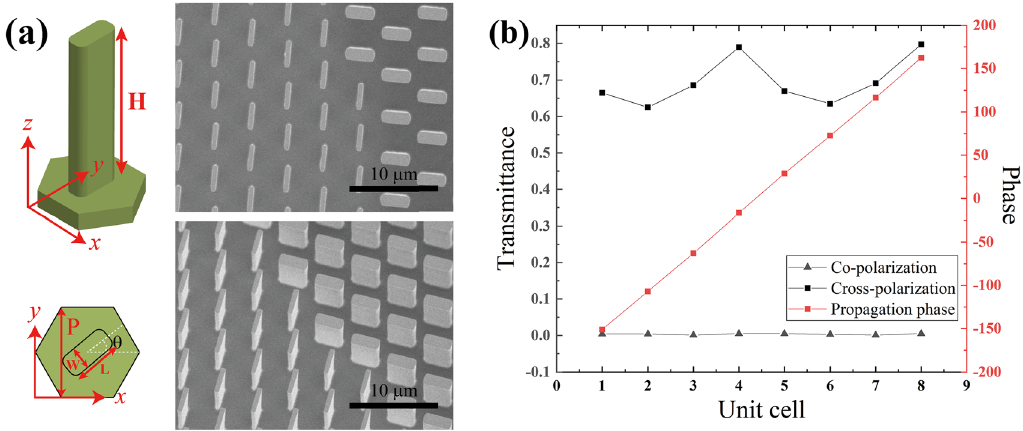
Figure 2: Design and simulation results of the unit cells. (a)Schematicimagesoftheunitcellandscanningelectronmicroscope(SEM)imagesofthesamples.Ahexagonalshapeisdesignedbecause the circular symmetry of the hexagonal shape is higher than the square, leading to more uniform responses of the unit cells at different rotation angles for Pancharatnam-Berry (PB) phase. The period P of the unit cell and the height H of the pillar are 4.8 and 7 μ m, respectively. The edges of the pillar in this design are bent by a radius of W /4, where W is the width of the pillar. (b) Simulation results of eight unit cells includingco-polarization,cross-polarizationtransmittanceandpropagationphaseat10.6 μ m.Thesizesofunitcells1 – 4are L